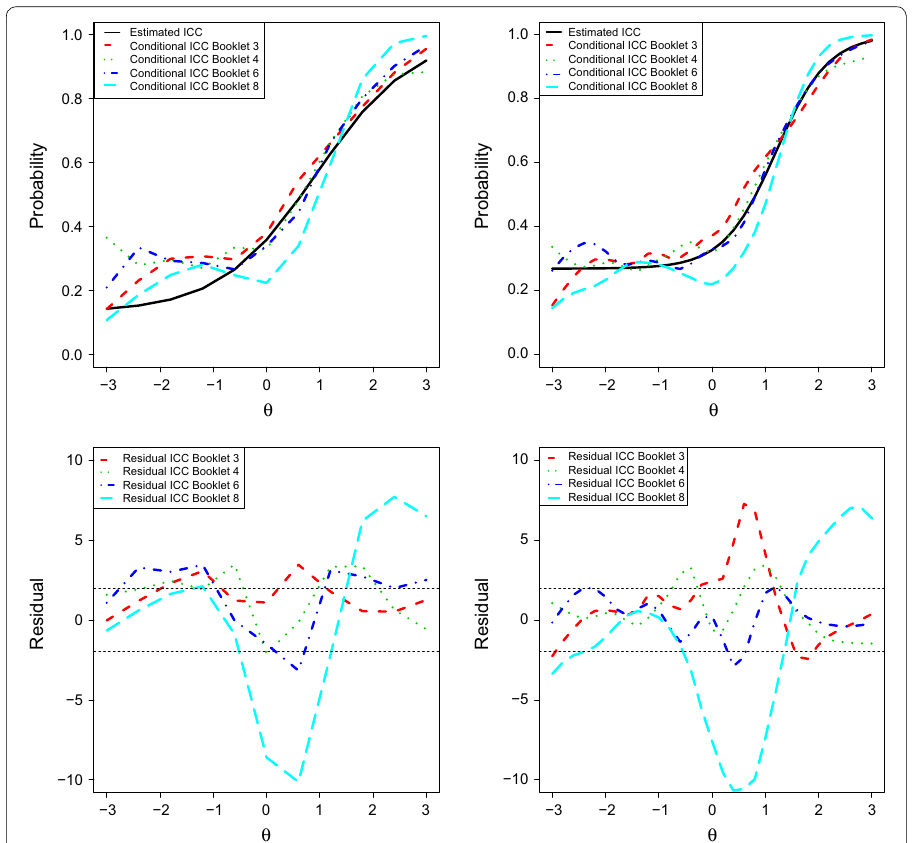
Fig. 6 Item-fit plots and residuals per booklet for an item from the 2008 long-term trend mathematics assessment at age 9 ( left C3PL, right